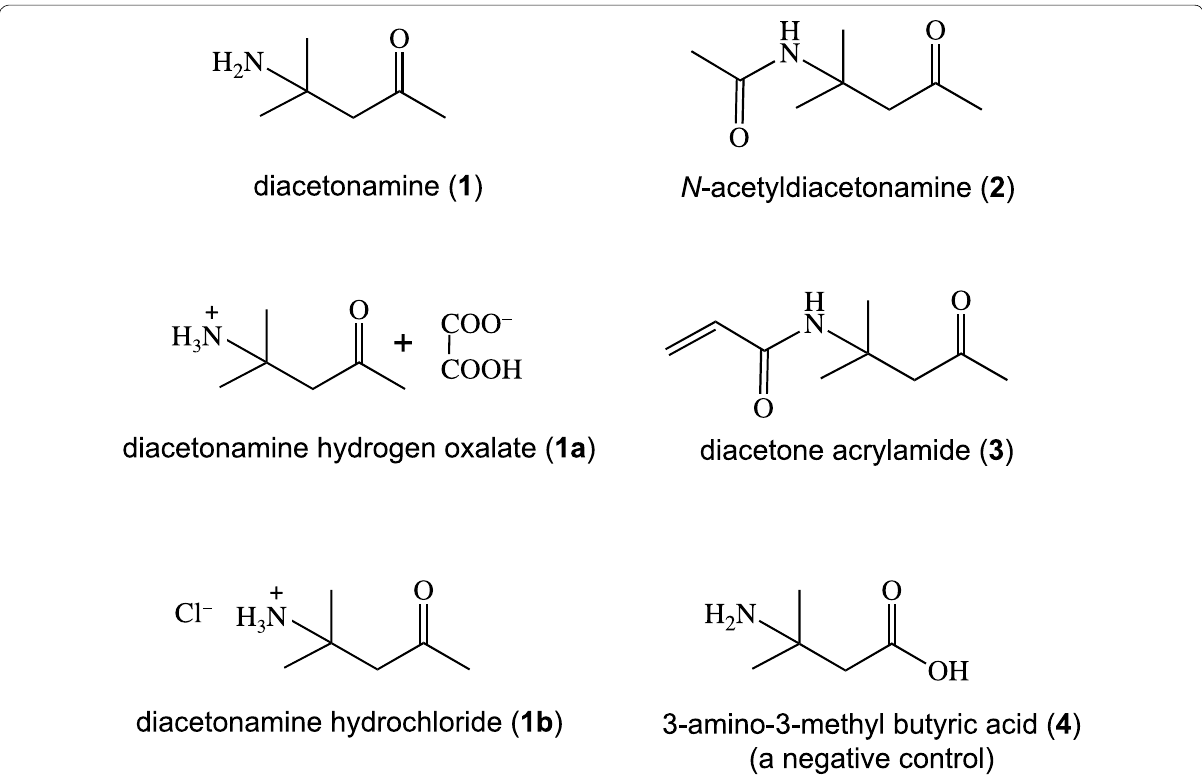
Fig. 2 Structures of diacetonamine and its related